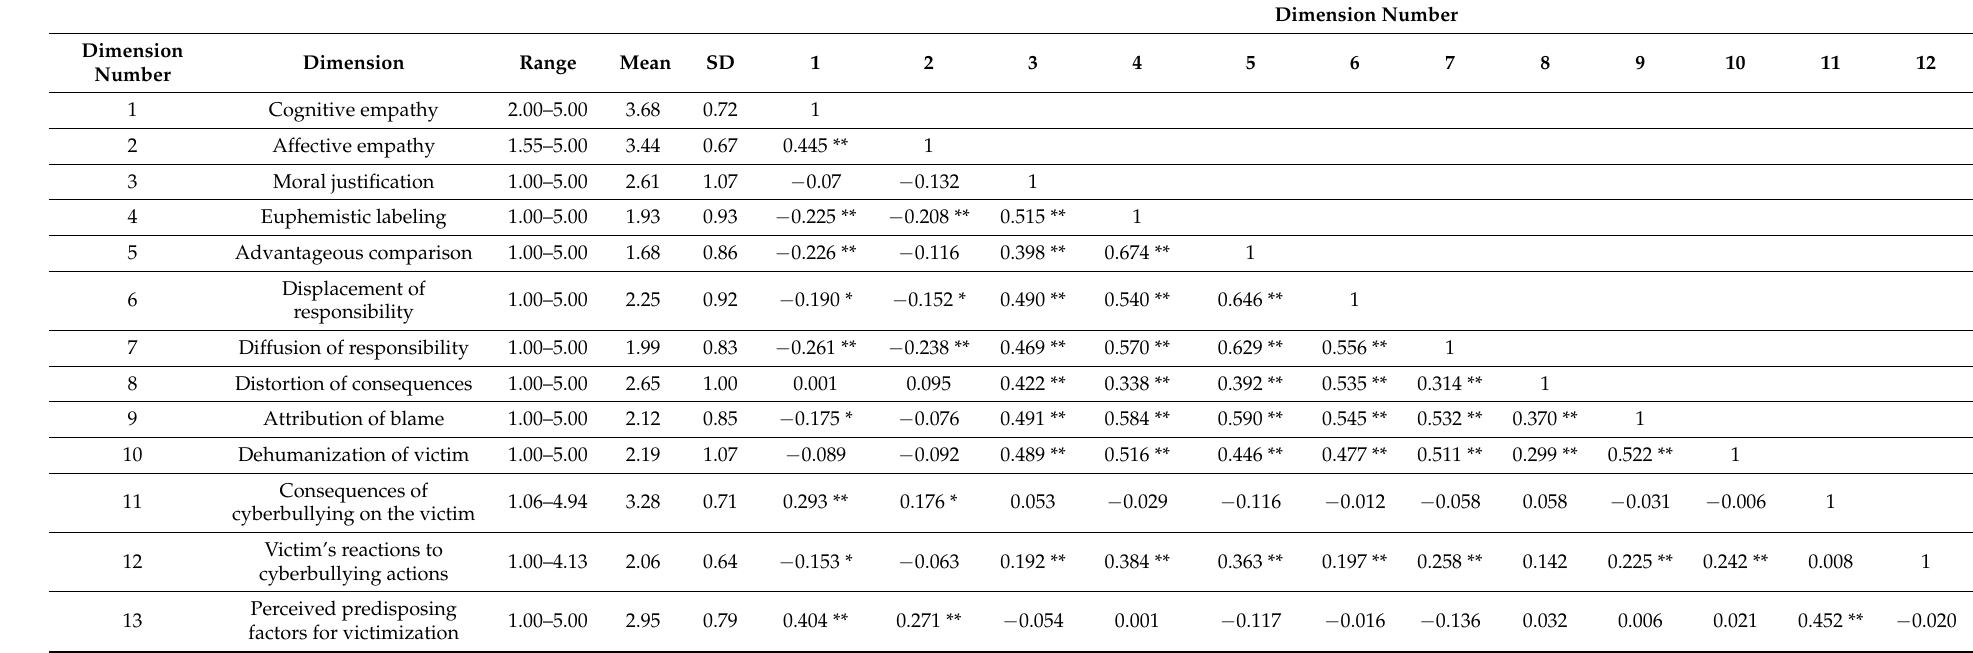
Table 2. Descriptive statistics and Pearson’s correlation between the dimensions